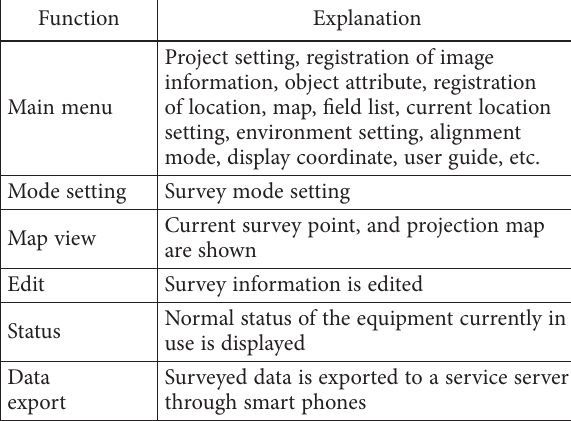
Table 3. Construction and explanation of survey